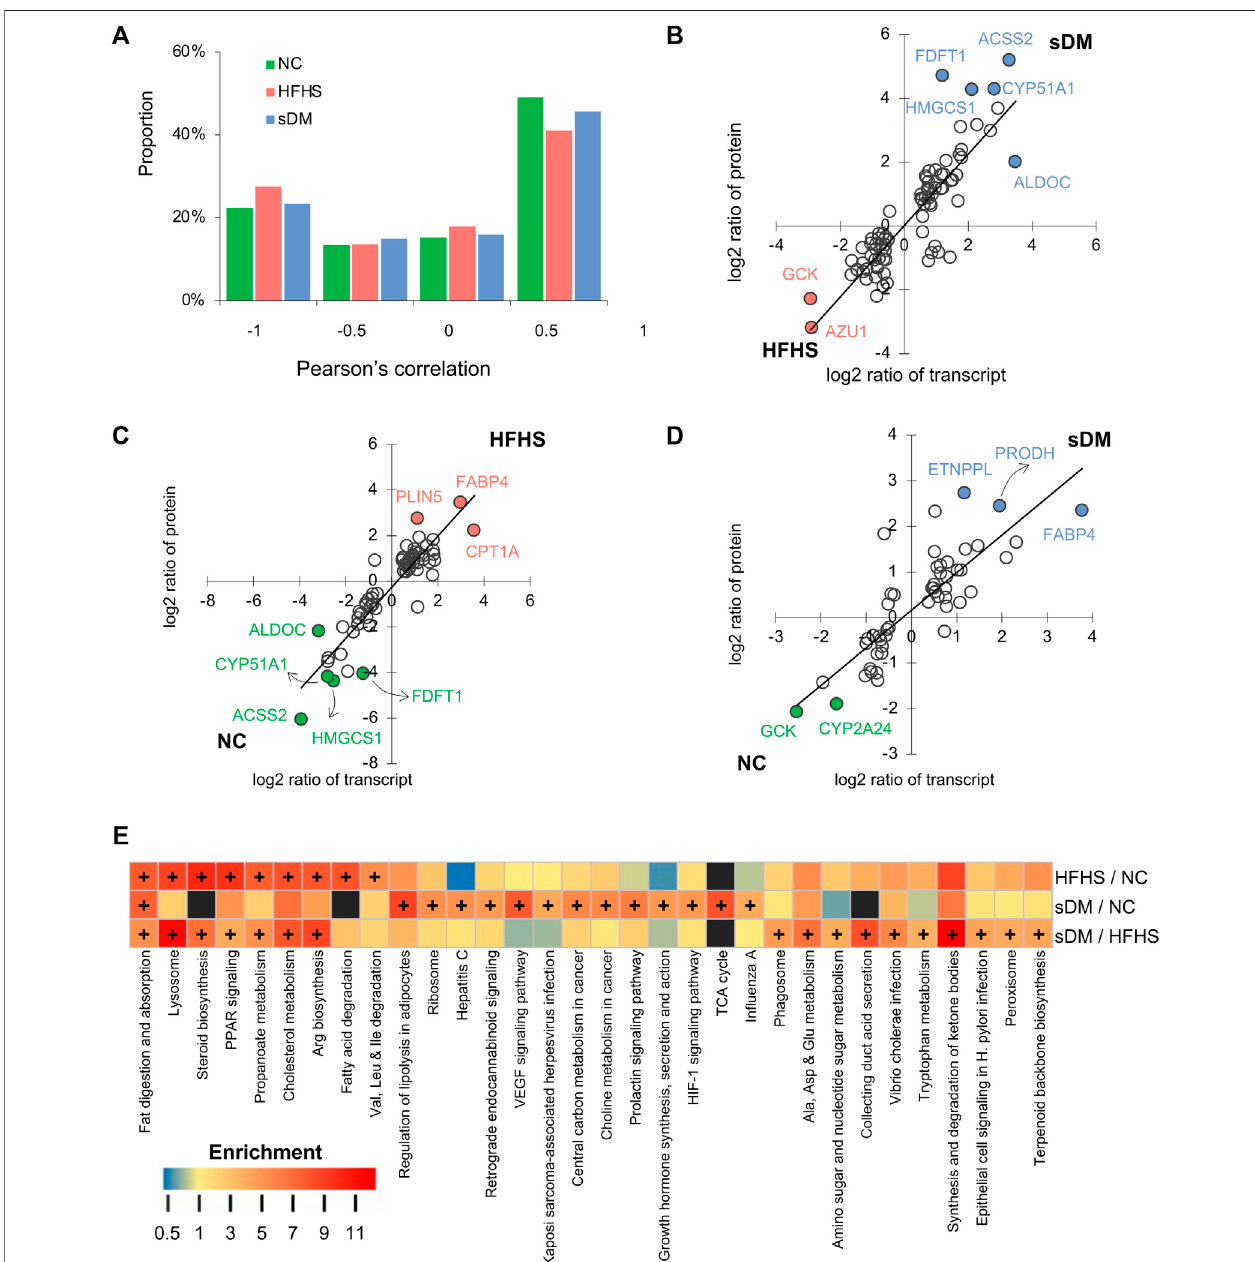
FIGURE 5 | Joint analysis of the multiomics data. (A) The proportion of genes whose proteins and transcripts showed positive ( > 0.5), negative ( < − 0.5), or no correlation(between − 0.5 and 0.5). (B – D) the comparisons oflog2 ratios ofprotein and transcript levels ofdifferential genes forsDM versusHFHS (B) , HFHS versusNC (C) , and sDM versus NC (D) . The black lines show the bisects y (cid:2) x. (E) The pathway enrichment analysis using the metabolomics and proteomics data jointly. Plus symbol (+) annotates the enriched pathways of signi fi cance.